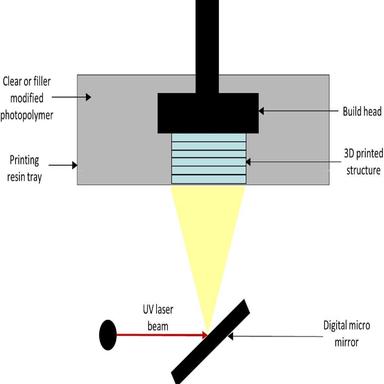
Schematic of a stereolithography process.